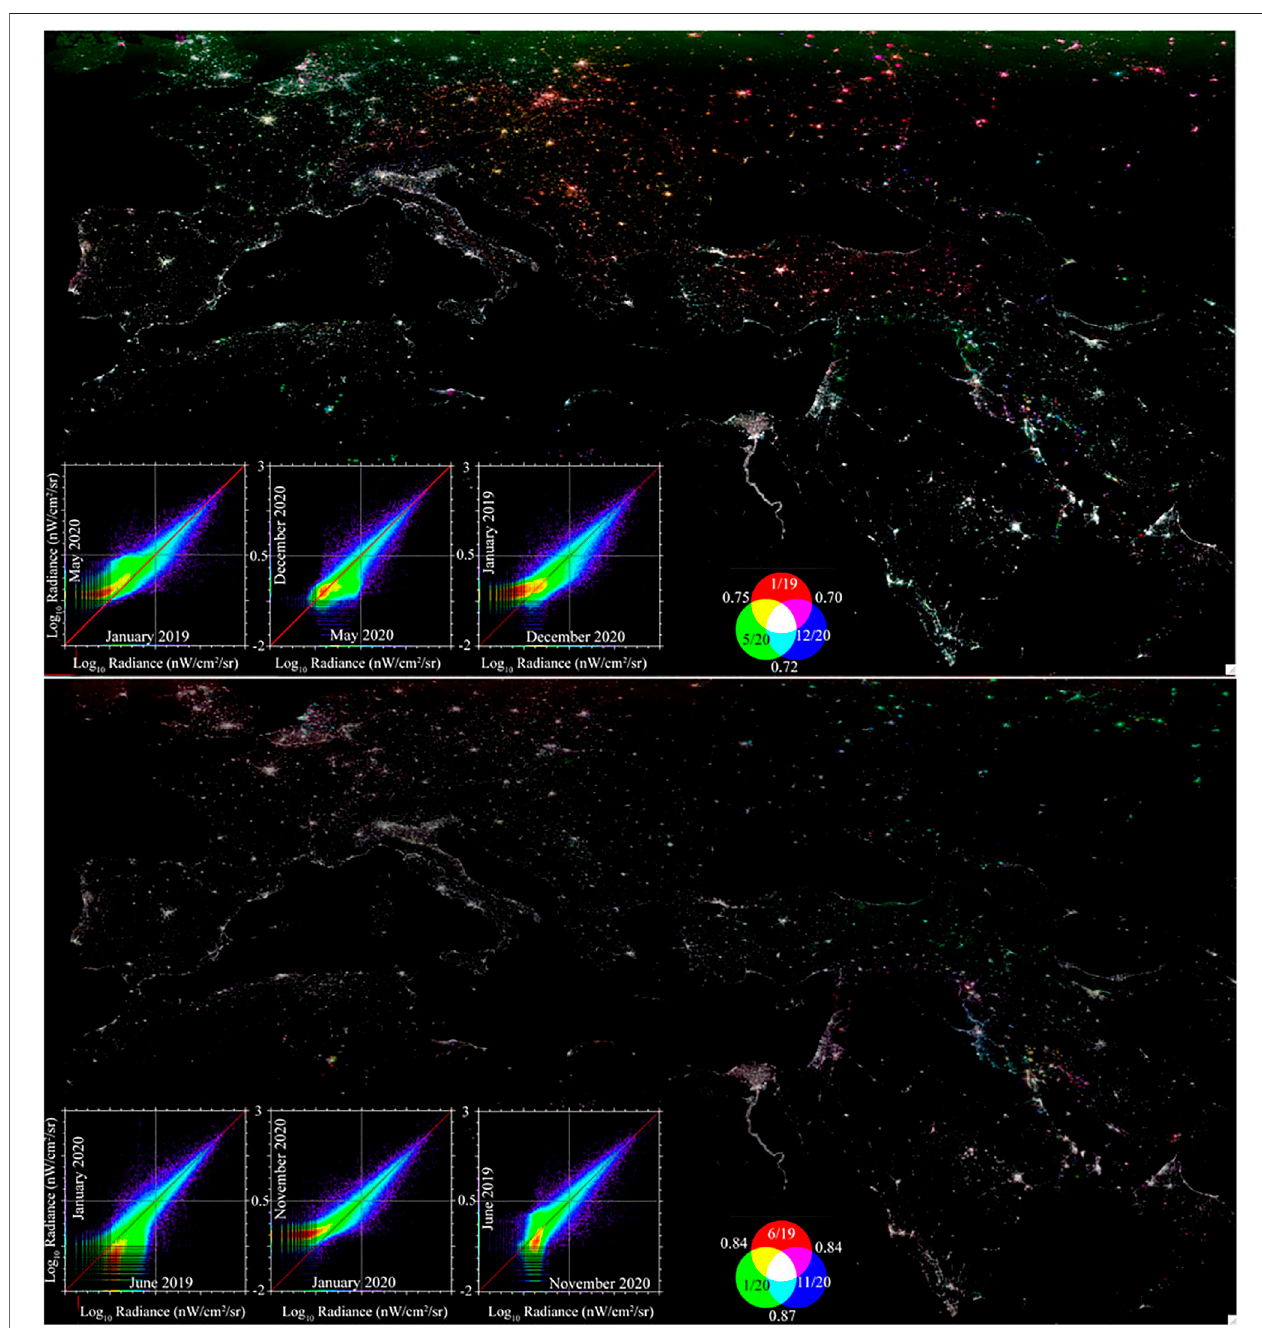
FIGURE 2 | Tri-temporal composites of lowest spatial correlation. Color implies change. May 2020 and December 2020 (top) have much lower correlation to all other months (inset RGB). Aside from these two anomalous dates, summer and winter pairs have lower correlations (bottom) than same season pairs, which are generally > 0.88. Correlations are computed using only pixels > 10 +0.5 nW/cm 2 /sr to exclude effects of background luminance changes. Note geographic contiguity of change areas.